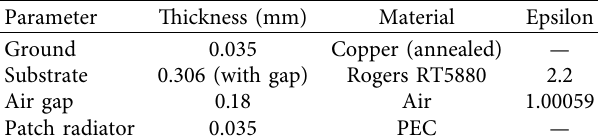
Table 1: Antenna materials.